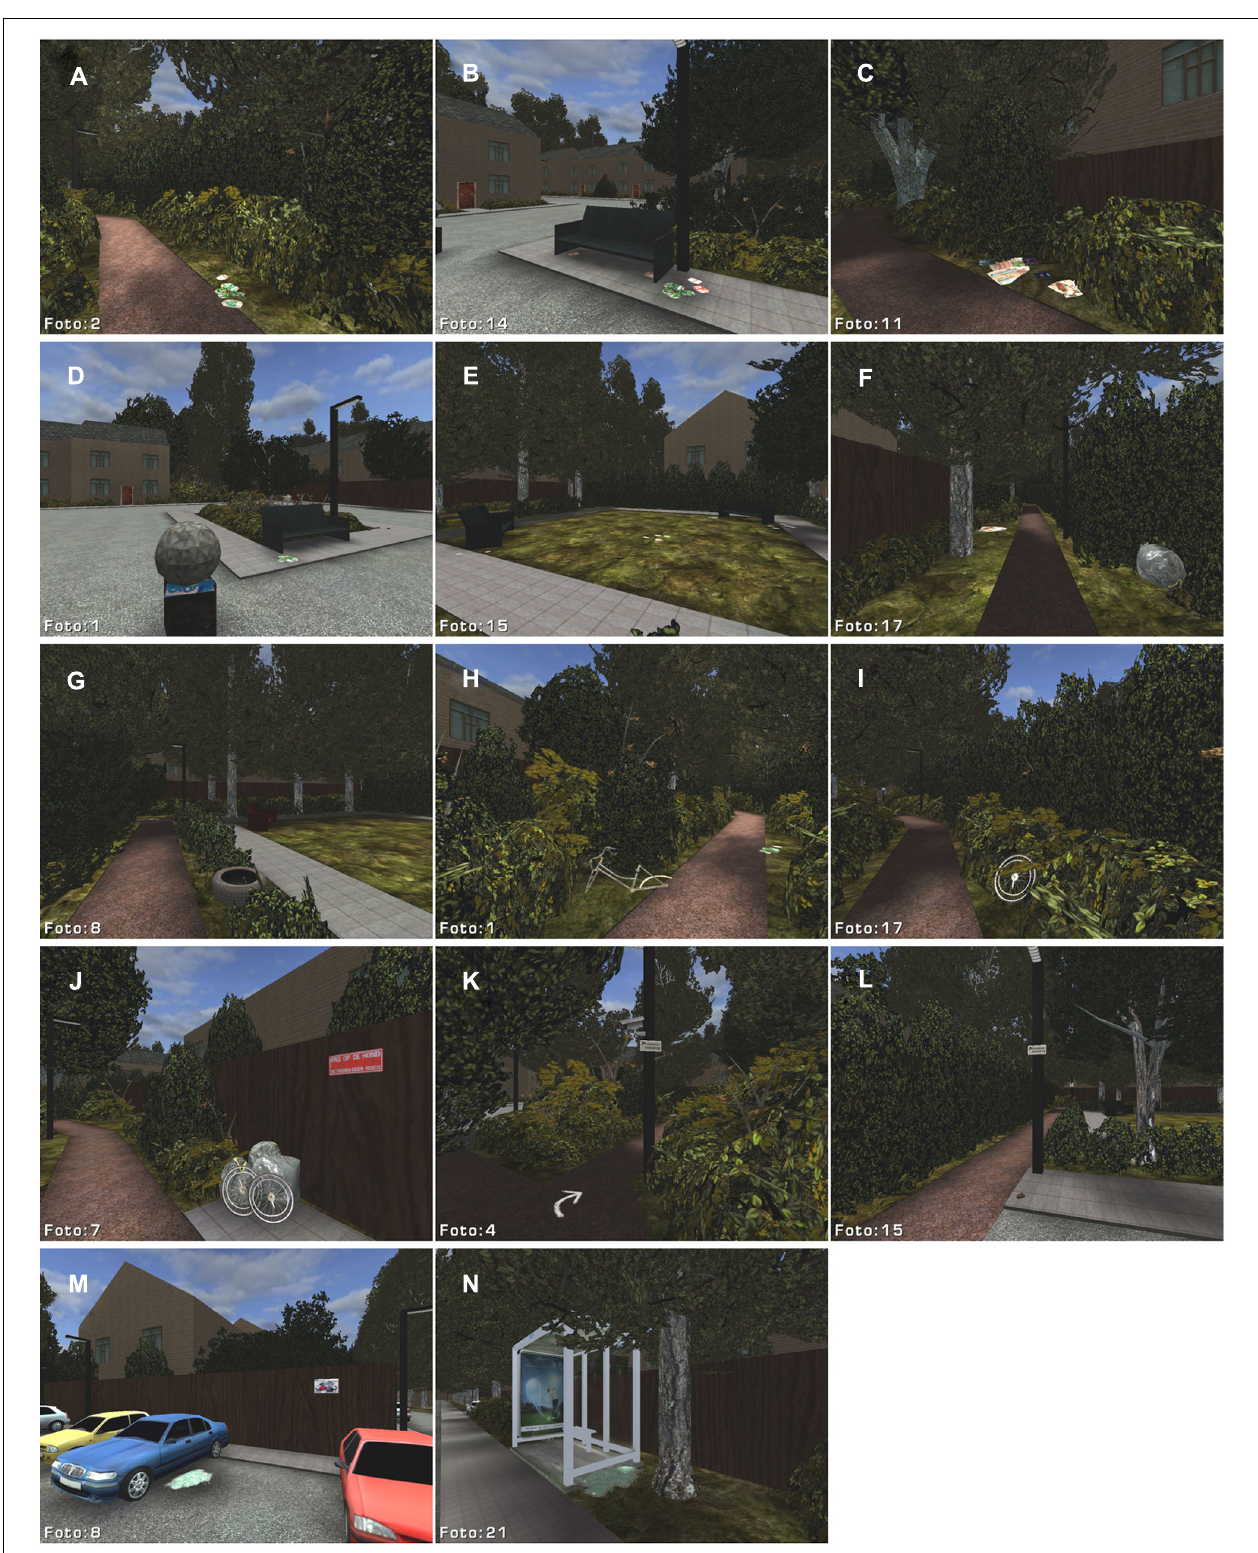
FIGURE 1 | Screen shots of the virtual environment, showing locations with litter (A–E), garbage (F,J), bicycle- and car parts (G–J), warning signs (J–M), cameras (K), and evidence of car burglary (M) and vandalism (N).